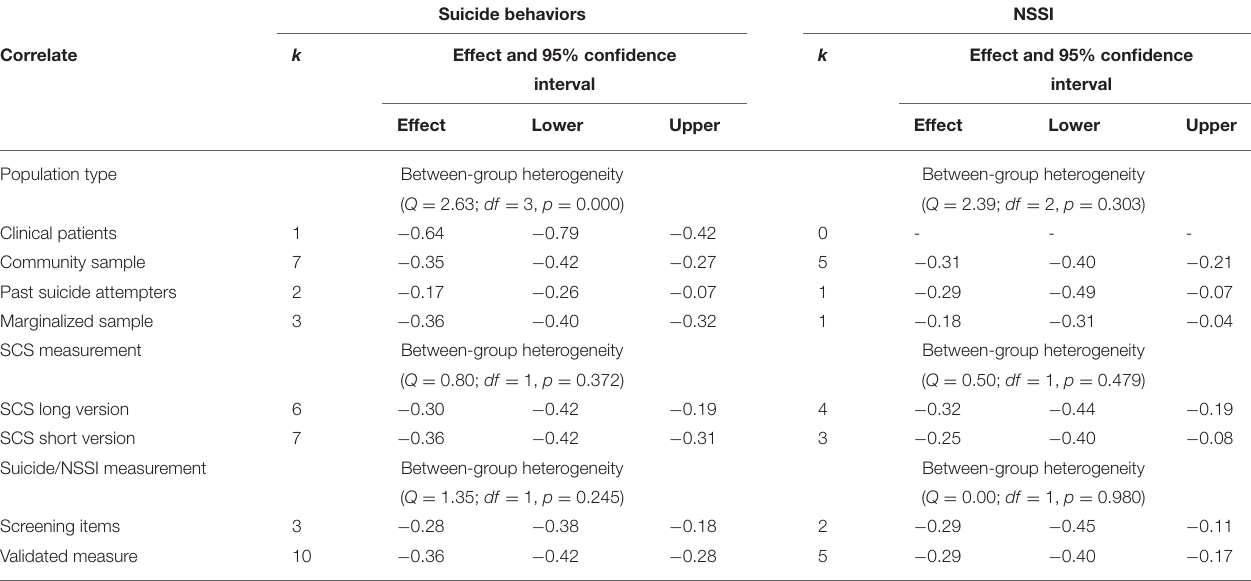
TABLE 4 | Moderation analysis results by population and measurement types.